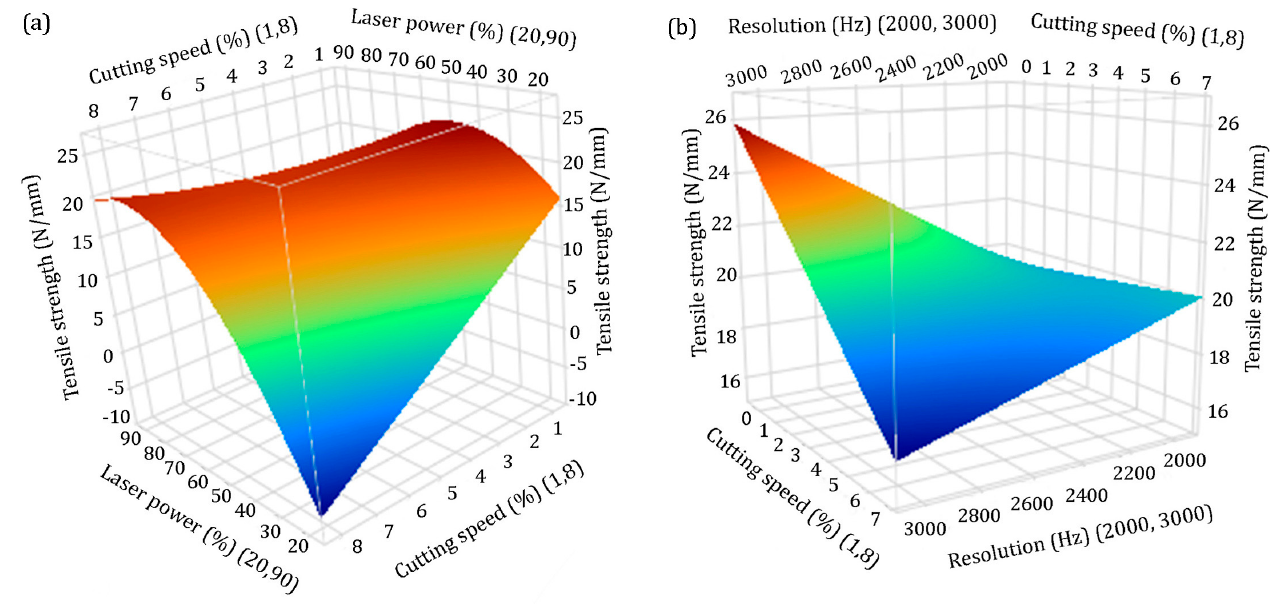
Figure 6. 3D response surface plots of statistically significant interactions, ( a ) laser power and cutting speed, ( b ) cu tt ing speed and resolution.